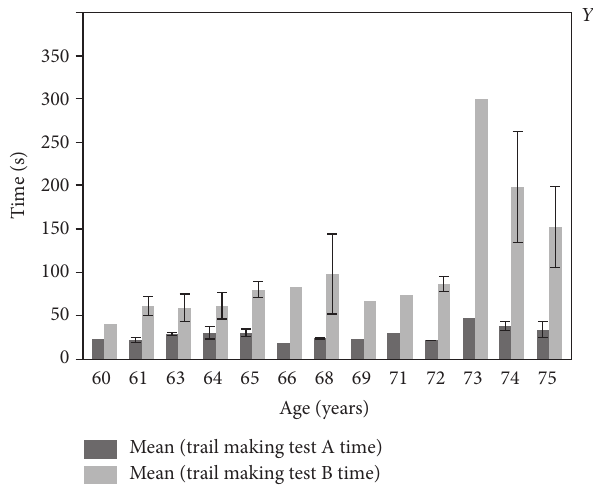
Figure 1: Mean performance in seconds on Trail Making Test Parts A and B by age. One row excluded. Each error bar is constructed using 1 standard error from the mean.